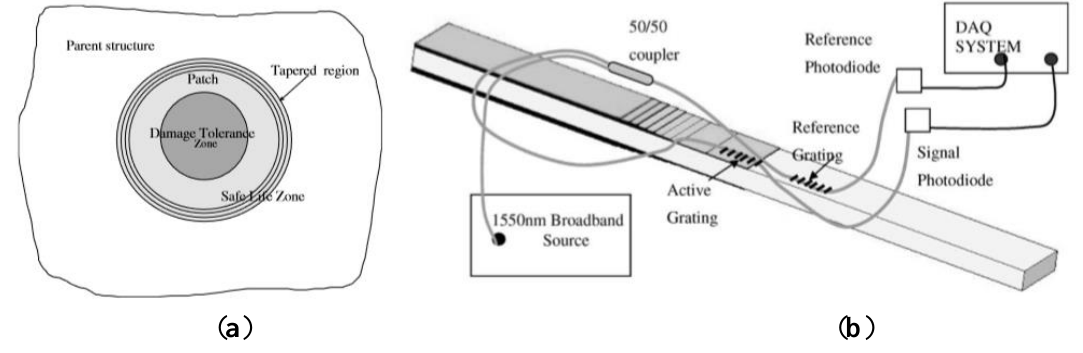
Figure 13. Safe life or damage tolerant areas of the composite patch ( a ) and SHM system for monitoring composite repair disbond with FBGs ( b ) (adapted from